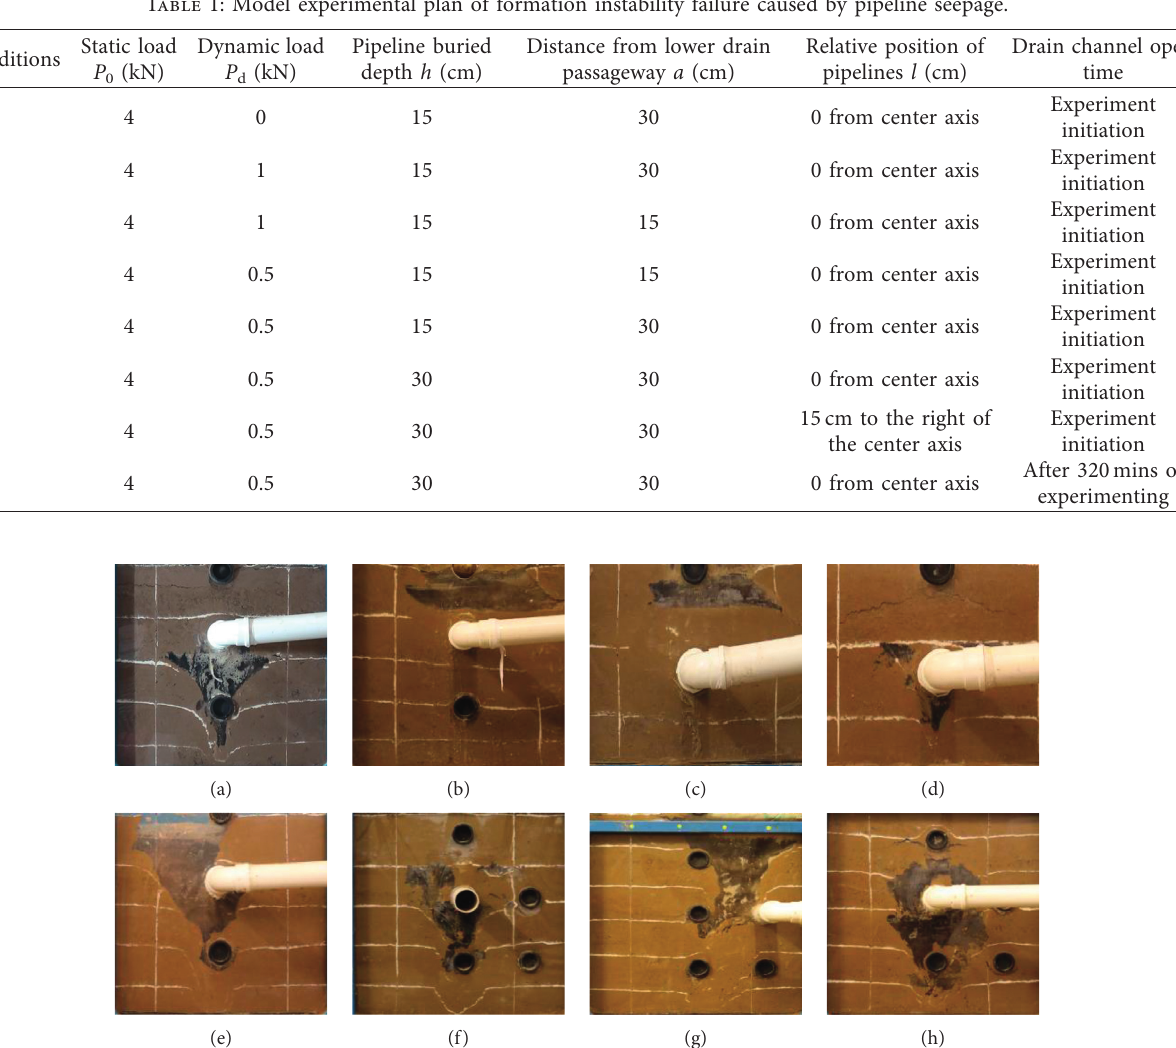
Table 1: Model experimental plan of formation instability failure caused by pipeline seepage.